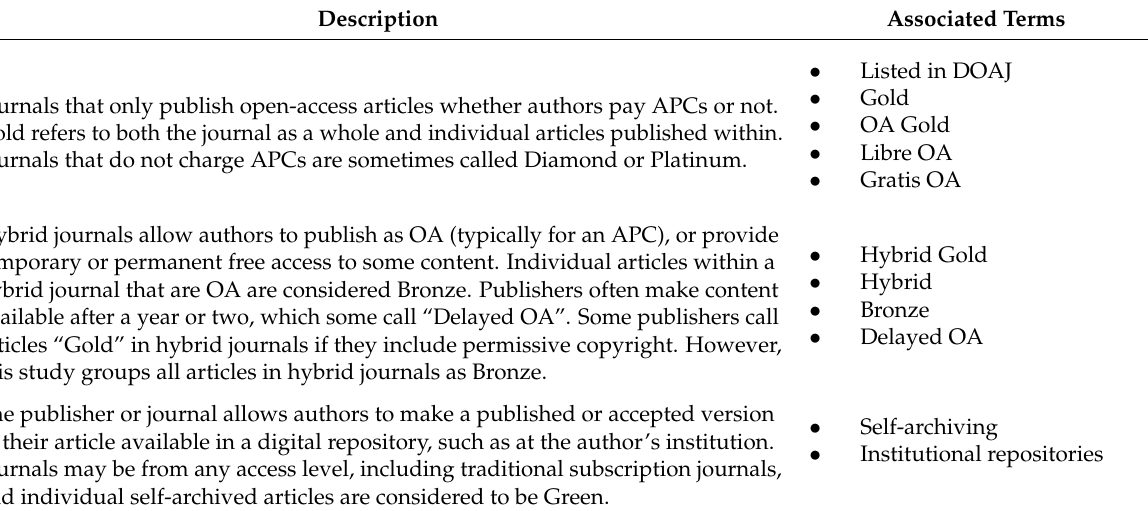
Table 1. Open-access (OA) level code and